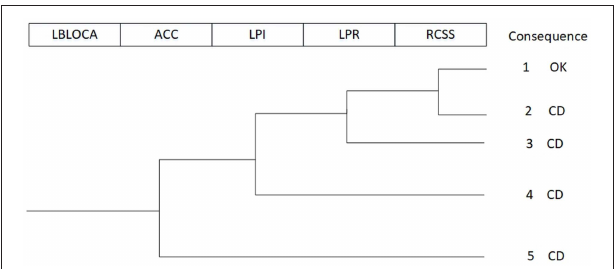
FIGURE 6 | Traditional ET model for a PWR